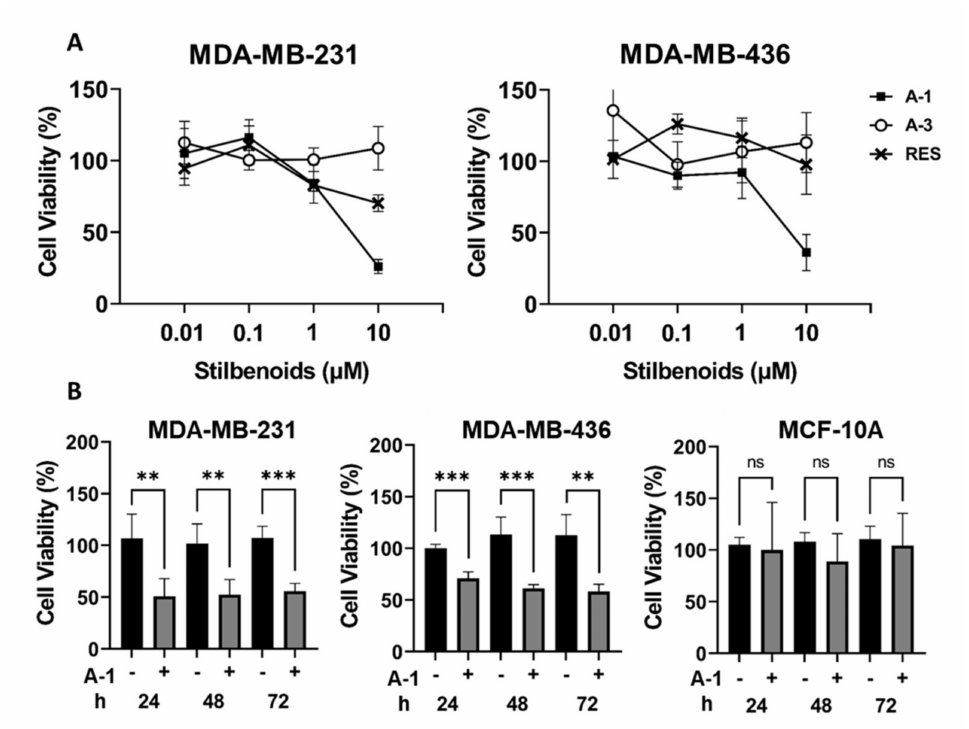
Figure 3. Effect of arachidin-1 (A-1), arachidin-3 (A-3), and resveratrol (RES) on growth inhibition. ( A ) MDA-MB-231 and MDA-MB-436 cells were treated with 10, 1, 0.1, and 0.01 µ M of RES, A-1, and A-3 for 72 h. ( B ) Comparison of the cytotoxicity of A-1 in different cell lines. Cells were treated with 1 µ M of A-1 for 24, 48, and 72 h. Cells with 0.1% DMSO were used as controls, wherein n = 3. Each bar represents the mean of three replicates ± SD. ** p < 0.001, *** p < 0.0001, and ns = not significant relative to